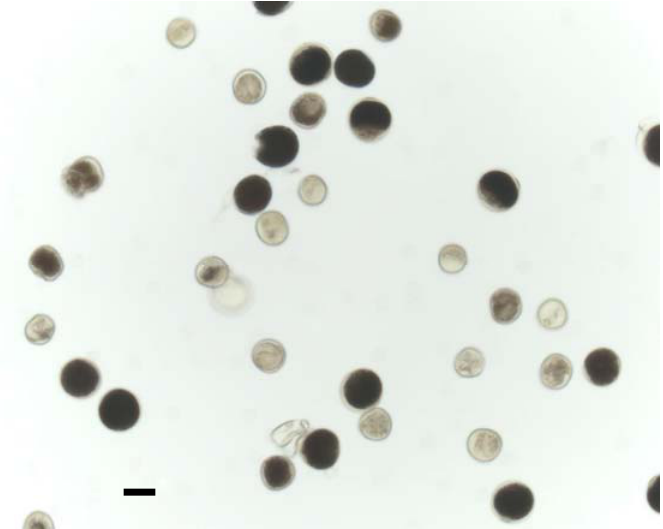
Figure 9. Segregation (~1:1) of viable and non-viable pollen (dark and light) in T of a p Zm13 Pro:: barnase event is shown via IKI staining. Pollen was collected from just prior to anthesis and stained in 5% IKI solution. Scale bar = 0.5 µm